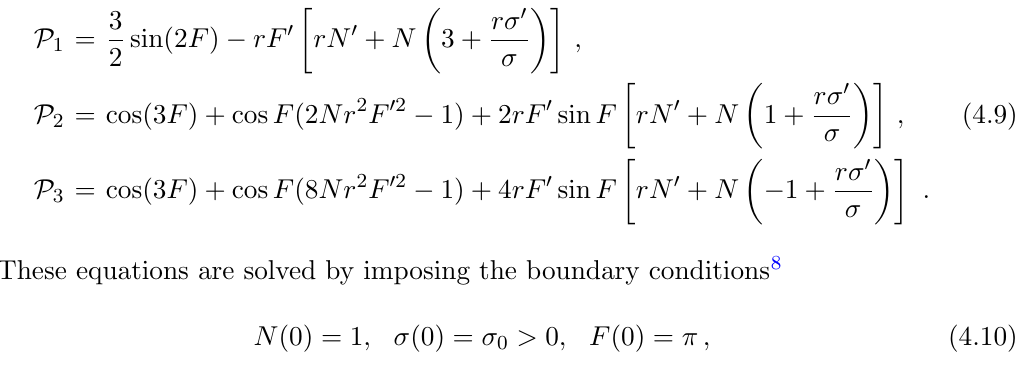
Figure 3 . Left panel: the pro(cid:12)le functions of a typical spherically symmetric Skyrme star. Right panel: the total mass M , the control parameter f 1 and the value of the metric function (cid:27) at the origin are shown as a function of coupling constant, (cid:11) , for spherically symmetric Skyrme stars.